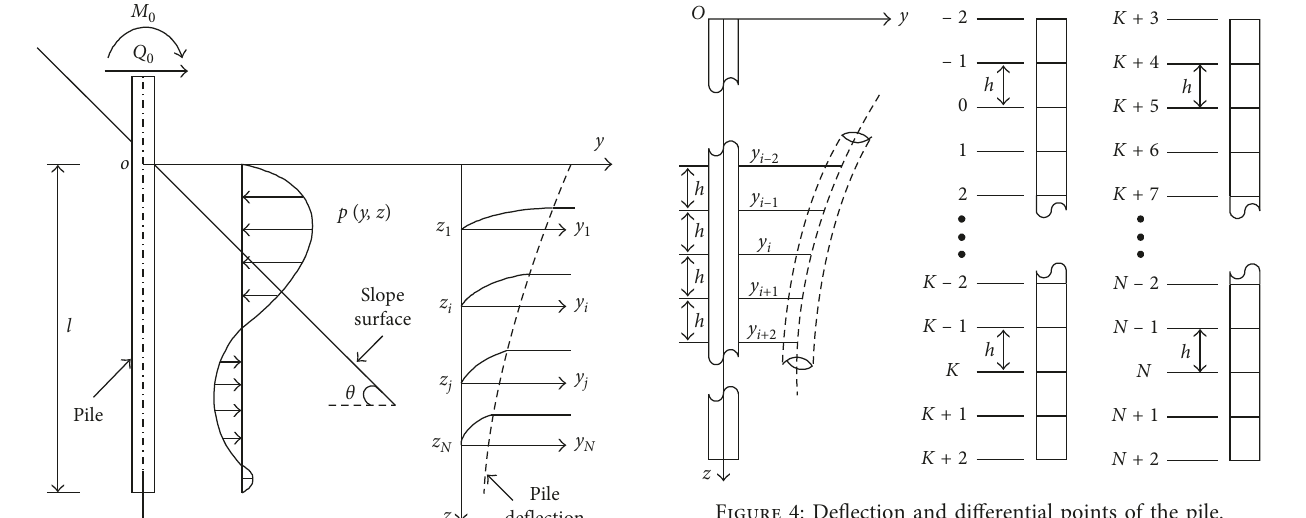
Figure 4: Deflection and differential points of the pile.